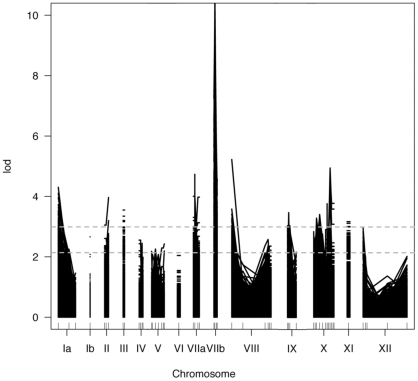
Genome-wide QTL map of strain-specific differences in host gene expression in infected chicken embryonic fibroblasts.SL-29 chicken embryonic fibroblasts were infected with 21 F1 progeny from a Type II x Type III cross and host gene expression at 24 hours post-infection was profiled by microarray. A one-dimensional genome-wide scan was conducted to identify Toxoplasma genetic markers associated with the expression level of each of the host genes represented on the microarray. The output of this QTL analysis is graphed here, where each line represents a host gene that mapped with a LOD score >2 to a Toxoplasma locus. To determine significance, p-values were calculated based on 500 permutations; genes that mapped to a parasite genetic locus with a p-value of <0.05 were considered significant. Threshold LOD scores for this p-value varied on a gene-by-gene basis from 2.10 to 3.14 and are represented by the two dotted gray lines overlaying the graph.